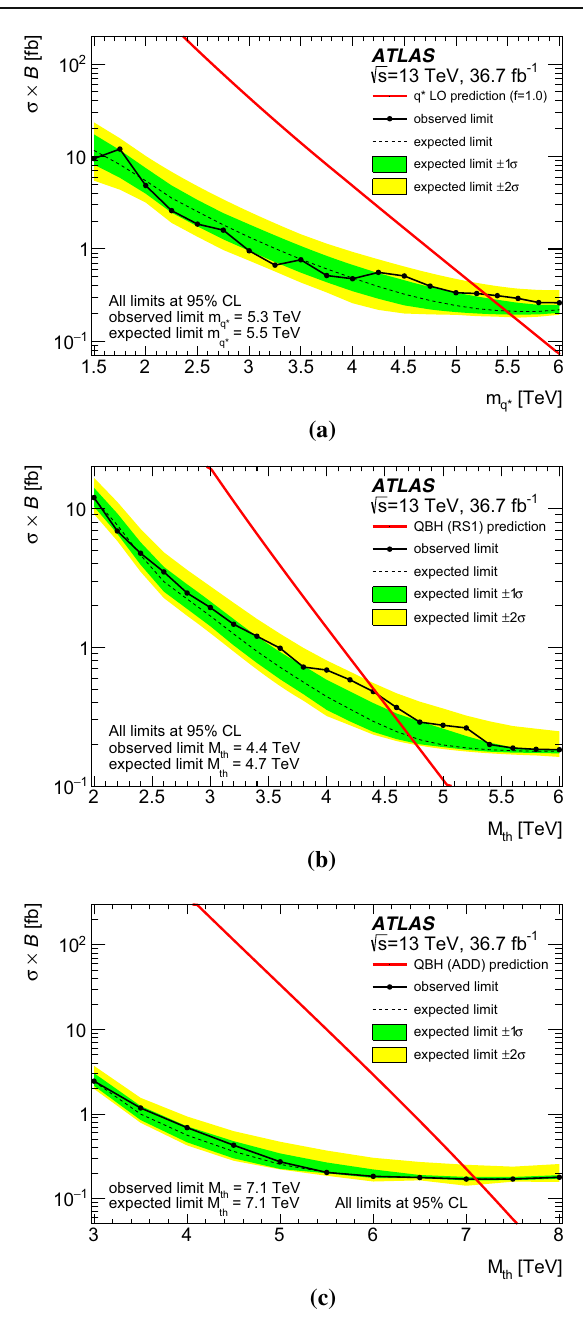
Fig. 6 Observed 95% CL upper limits (solid line with dots) on the production cross-section times branching ratio σ · B to a photon and a √ s = 13 TeV for the a excited- quark or gluon in 36 . 7 fb − 1 of data at quarks, b QBH(RS1)with n = 1and c QBH(ADD)with n = 6models. The limits are placed as a function of m q ∗ for the excited quarks and M th for the QBH signals. The calculation is performed using ensemble tests at mass points separated by 200 (500) GeV for the RS1 (ADD) model over the search range. For the q ∗ model the step size is 250 GeV up to 5 TeV and then 200 GeV up to 6 TeV. The limits expected if a signal is absent (dashed lines) are shown together with the ± 1 σ and ± 2 σ intervals represented by the green and yellow bands, respectively. The theoreticalpredictions of σ · B for the respective benchmark signals are shown by the red solid